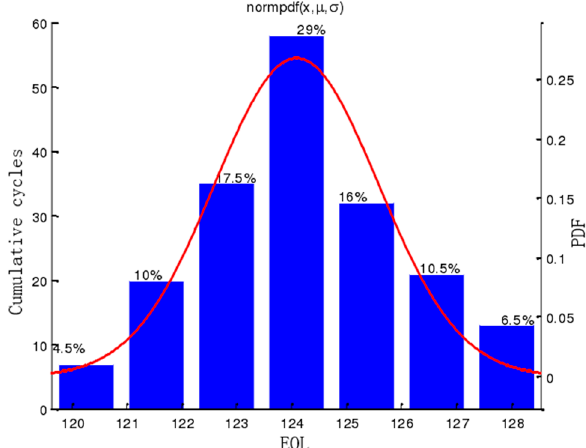
Figure 11. The probability distribution histograms (PDH) of LSTM prediction results at T1 = 69.